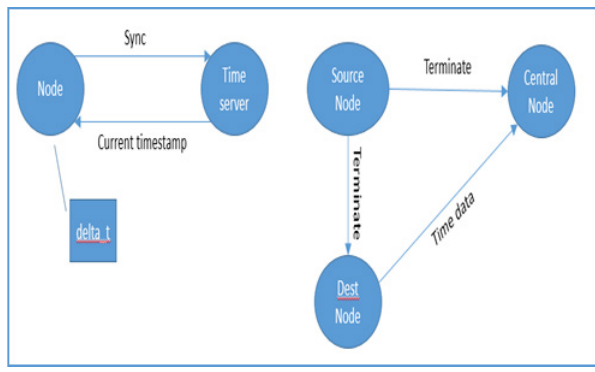
Fig. 5.Timeserver and Session Termination